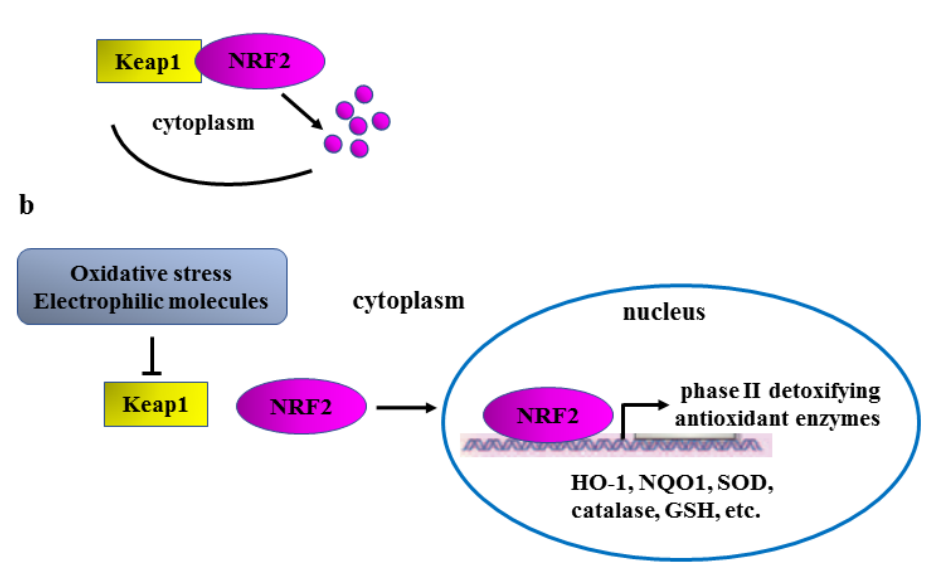
Figure 1. Schematic representation of Keap1/NRF2 regulation. ( a ) In unstressed conditions, Keap1 binds to NRF2, inducing its proteasomal degradation (purple dots). ( b ) Oxidative stress or electrophilic molecules change Keap1 conformation (inverted T sign), impairing Keap1/NRF2 binding (left part); NRF2 is therefore stabilized and can translocate into the nucleus to activate the transcription of phase II detoxifying/antioxidant genes (right part).